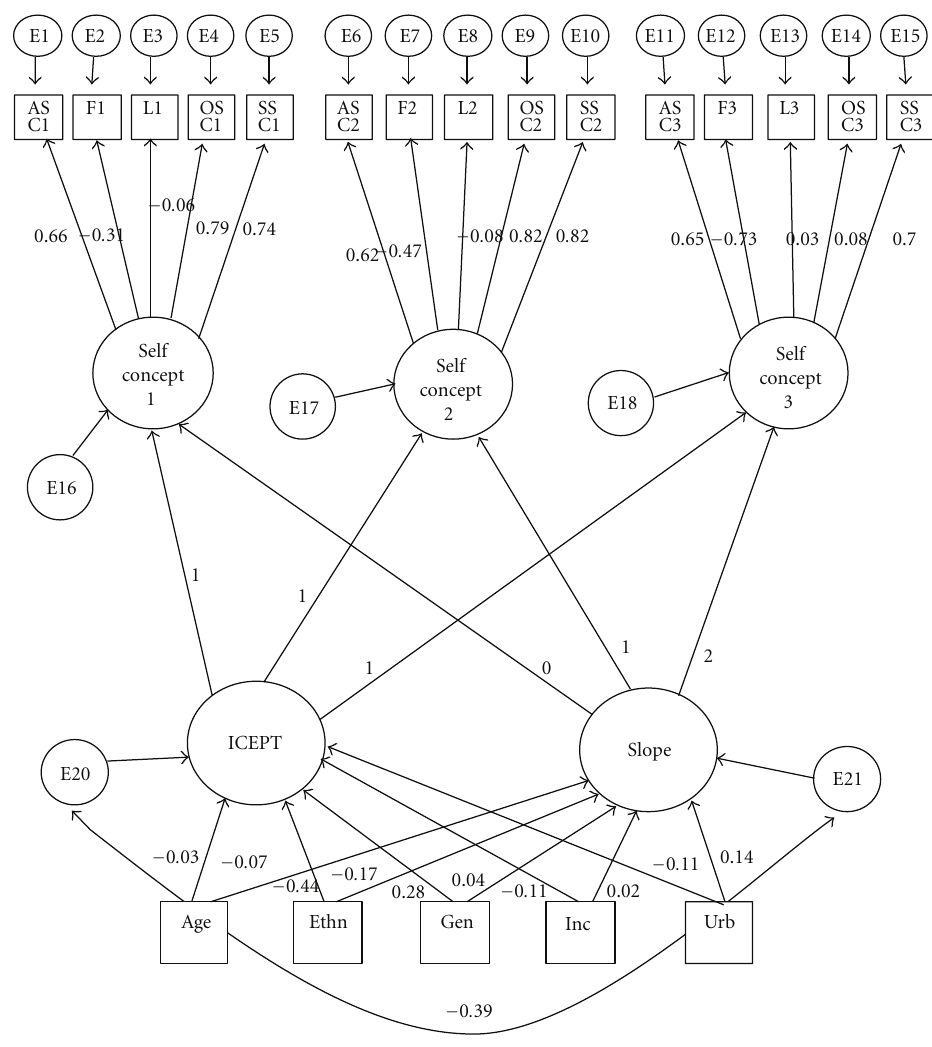
Figure 2: Full latent growth model with time invariant predictors. All variable labels are the same as those in Figure